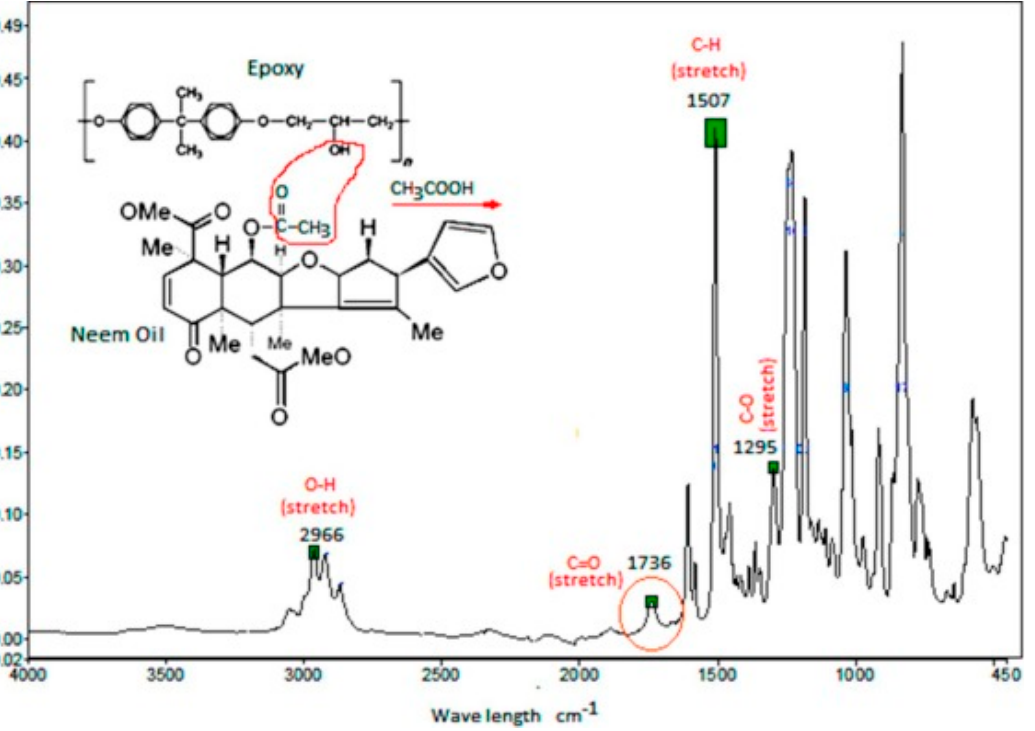
Figure 11. FT-IR spectra of acetic acid in epoxy-neem matrix [174] (Reprinted/adapted with per- mission from Elsevier Ref. 5457231434763 Copyright 2019). sion from Elsevier Ref. 5457231434763 Copyright